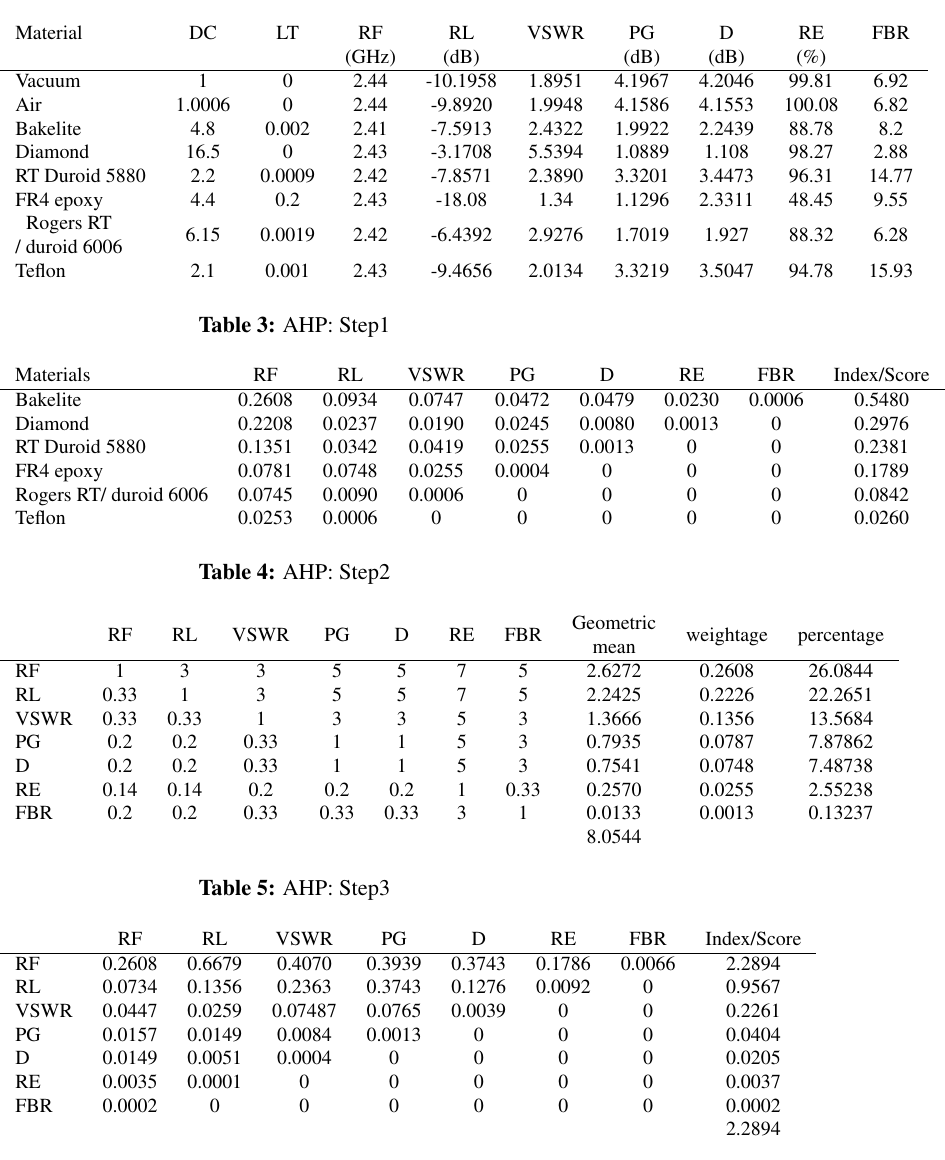
Table 6: Comparison of all the three methods of decision